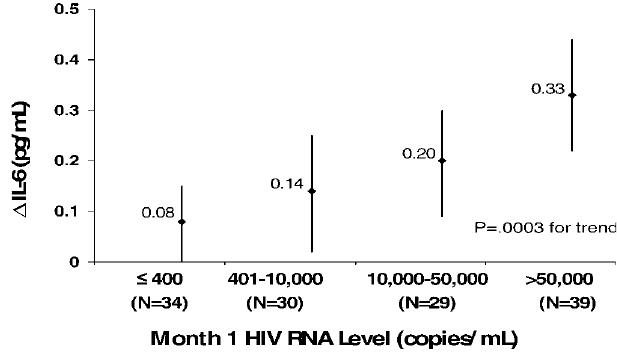
Figure 3. Change in Log 10 IL-6 (pg/ml) from Baseline to 1 mo According to HIV-RNA Level at 1 mo for Participants in the Drug Conservation (DC) Group (CD4 þ Guided Intermittent ART) with an HIV-RNA level 400 Copies/ml or Less at Baseline